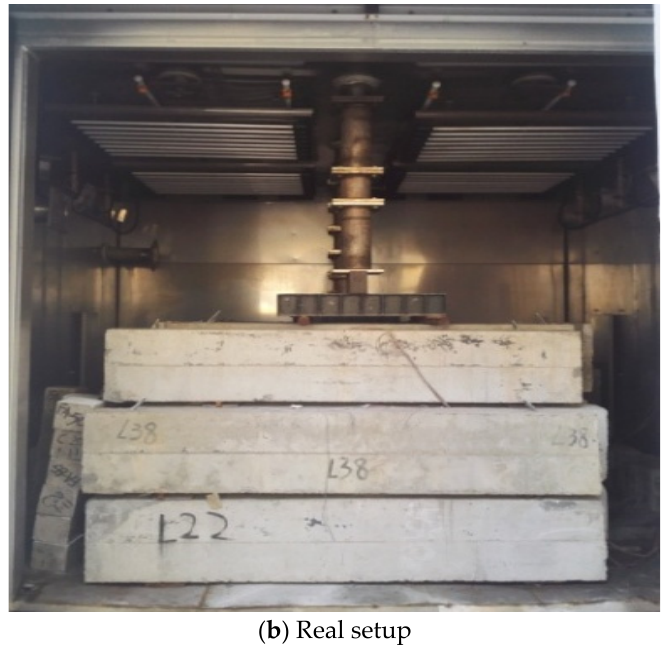
Figure 2. Experiment setup of accelerated deterioration experiment of reinforced concrete beams subjected to sustained loading and multi-environmental factors: ( a ) schematic and ( b ) real setup.